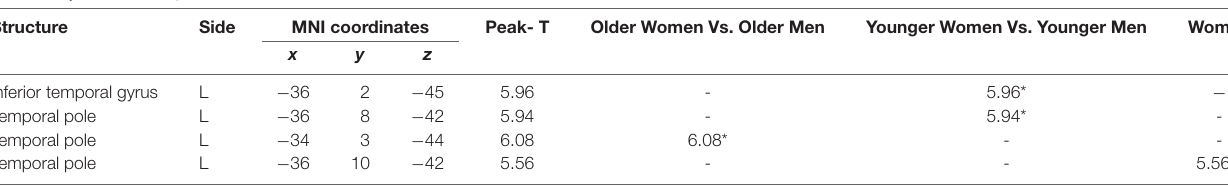
TABLE 6 | Gender comparisons.